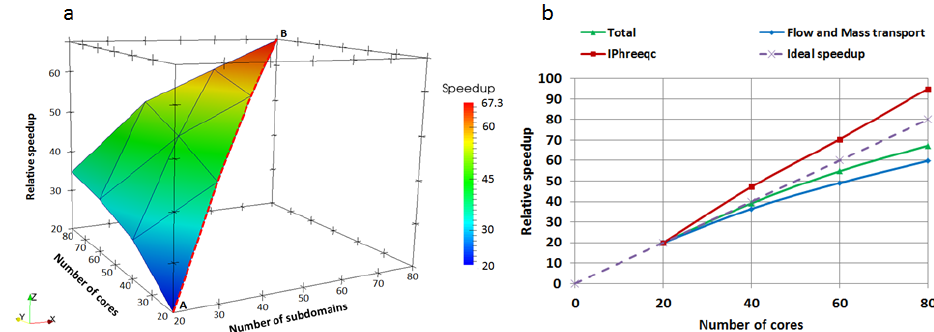
Figure 9. Performance of the parallelization scheme for the simulation of the 3-D test example on EVE cluster. (a) Relationship between number of DDCs, number of compute cores and relative speedup to 20 compute cores. (b) Breakdown of the speedup curve AB (marked as dashed line in a ) into speedup of calculation of chemical reaction, i.e., IPhreeqc and other